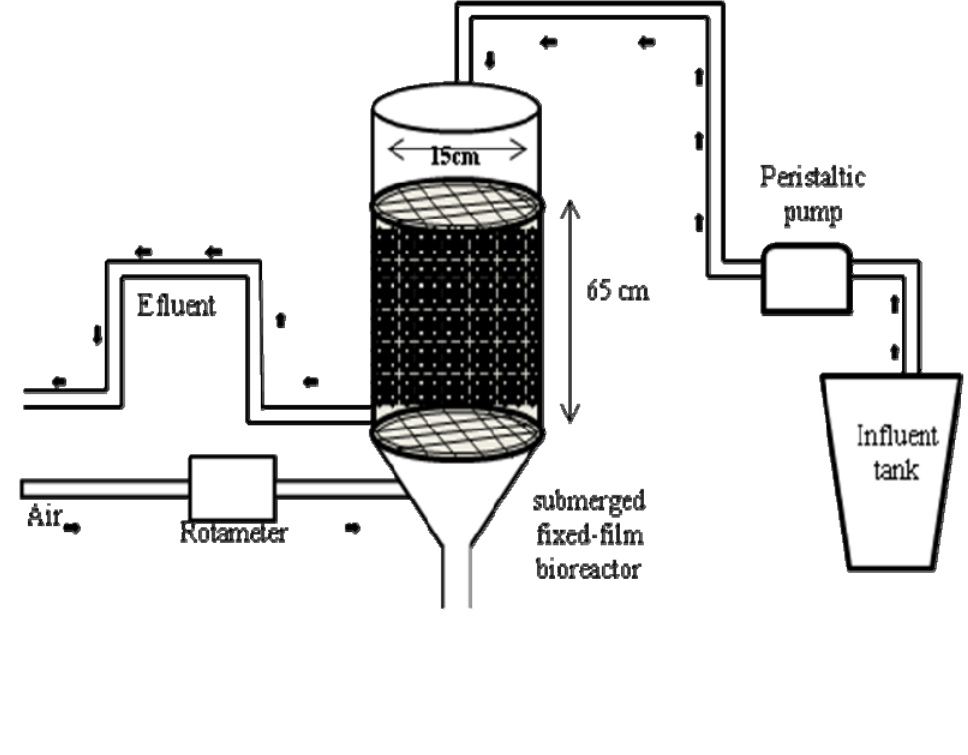
Figure 1. Diagram of submerged fixed-film bioreactor used for urban wastewater treatment constructed at bench scale and used in this